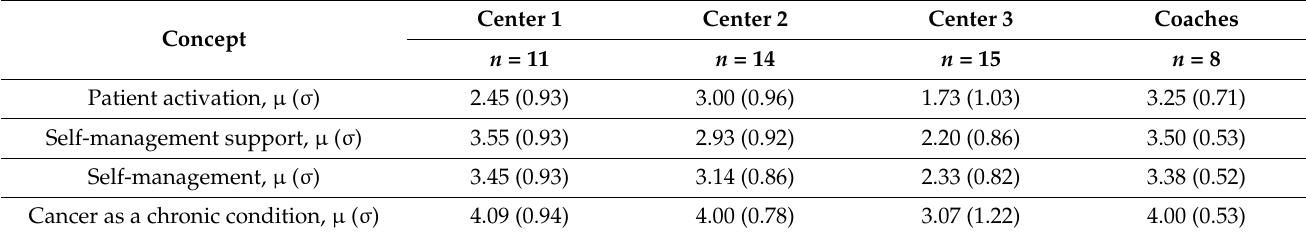
Table 2. Pretraining awareness of concepts of self-management and